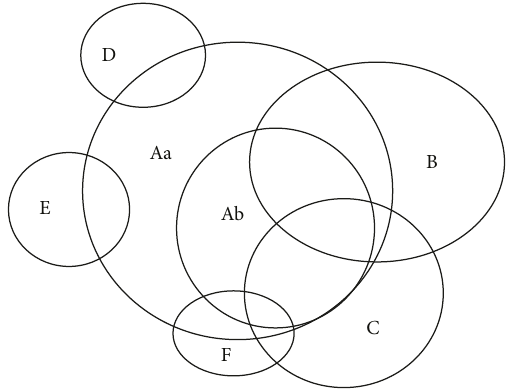
Figure 1: The circles “A,” “B,” and “C” represent (1) the axial spondyloarthritis (axSpA); (2) the peripheral SpA, and (3) the extra- articular manifestations of SpA, respectively. Within the axSpA (circle A) the two subcomponents are “Aa” and “Ab” that represent nonradiographic axSpA (nr-axSpA) and radiographic axSpA (r- axSpA), respectively. Circles “B,” “C,” “D,” “E,” and “F” represent (i) peripheral arthritis of SpA pattern, (ii) extra-articular features, (iii) inflammatory bowel disease-related SpA, (iv) psoriasis-related SpA, and (v) reactive arthritis-related SpA. Patients in circle “A” are often identified as “primary” SpA and those in circles “C,” “D,” or “E” as “secondary”